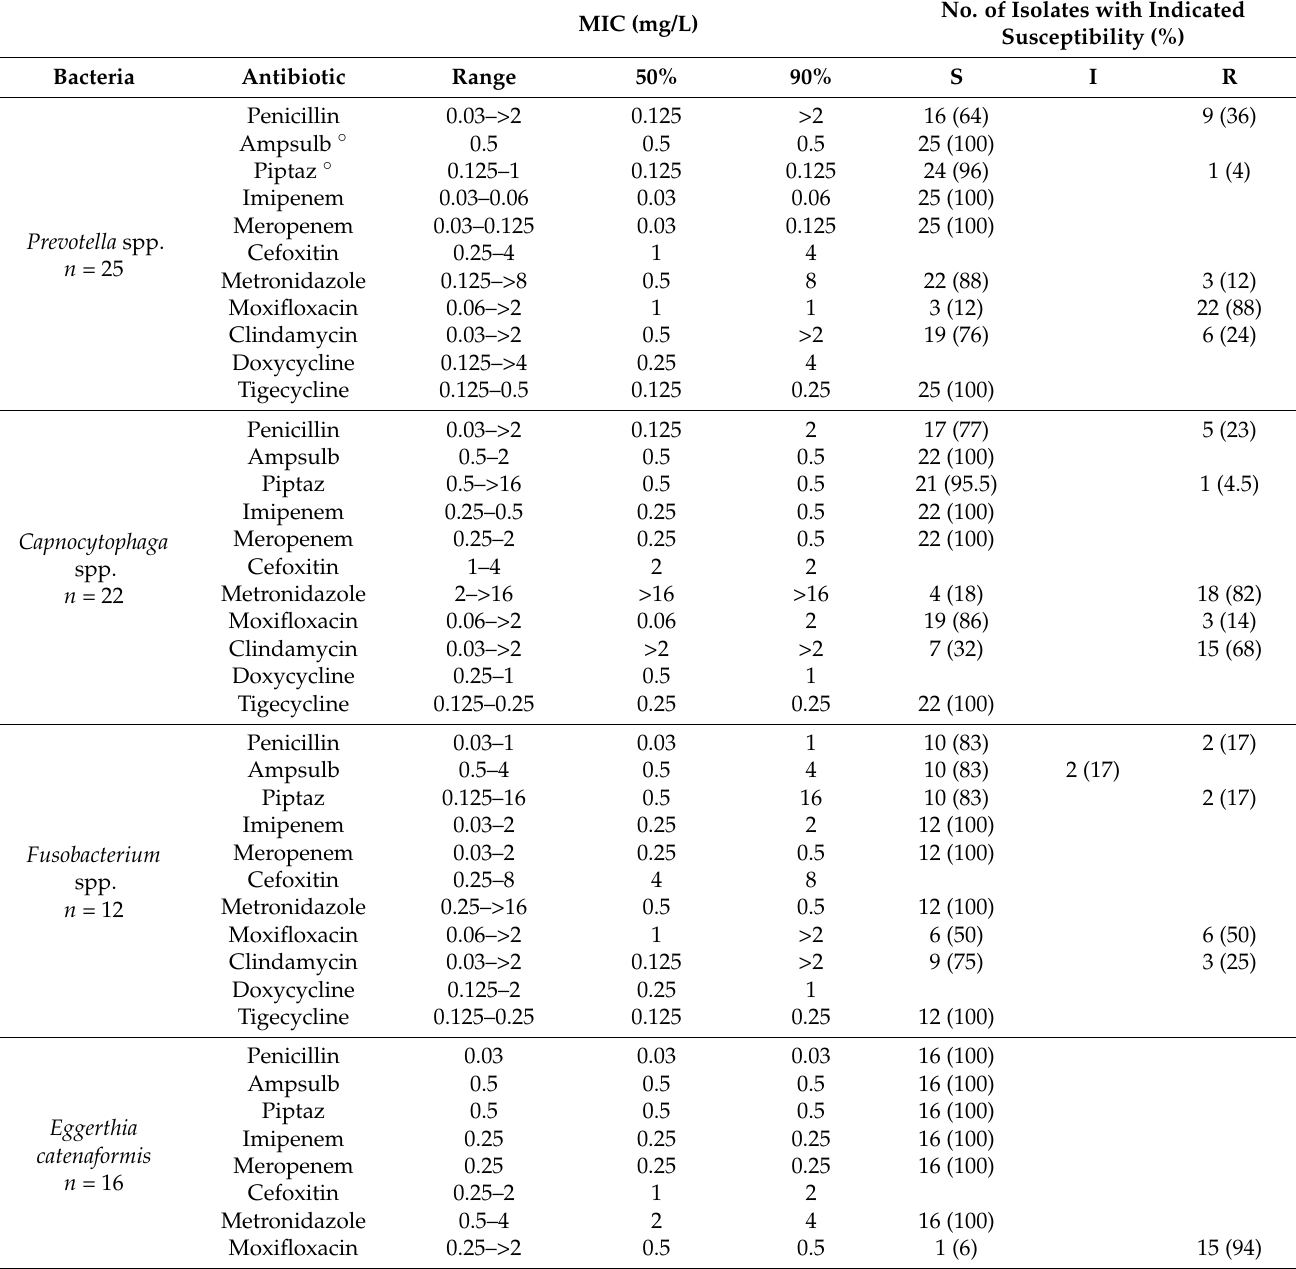
Table 1. Antimicrobial susceptibility of 120 anaerobic bacteria tested with agar dilution method. No. of Isolates with MIC (mg/L)